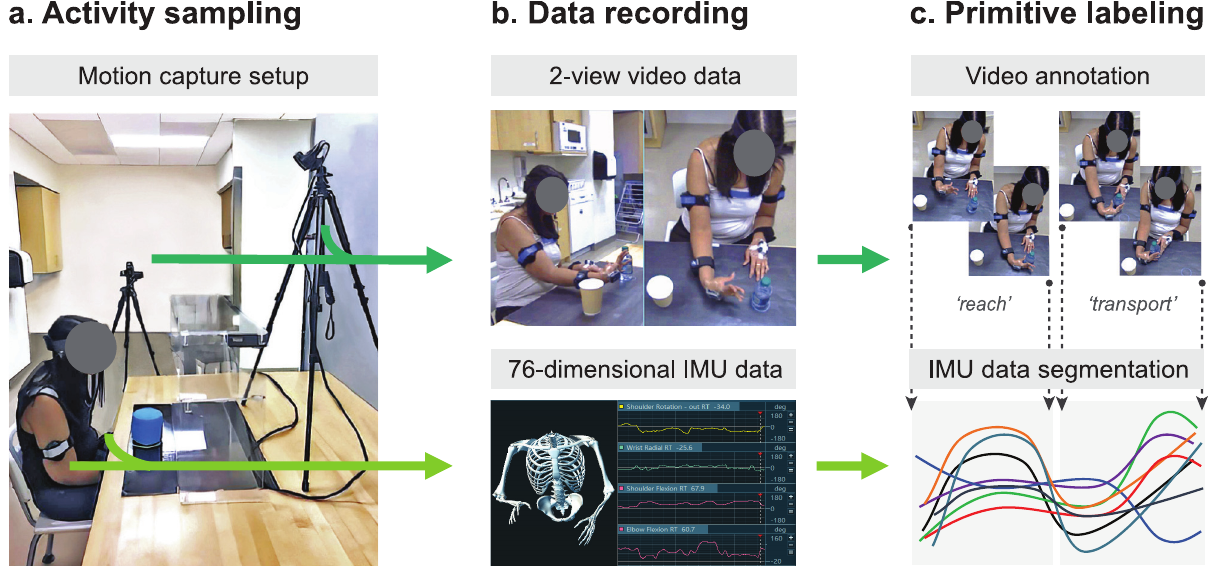
Fig 1. Functional motion capture and labeling. (A) Activity sampling . As patients performed rehabilitation activities, functional motion was synchronously captured with two video cameras (dark green arrow) placed orthogonal to the workspace and nine inertial measurement units (IMUs, light green arrow) affixed to the upper body. (B) Data recording . The video cameras generated 2-view, high-resolution data. The IMU system generated 76-dimensional kinematic data (accelerations, quaternions, and joint angles). A skeletal avatar of patient motion and joint angle offsets were monitored for electromagnetic sensor drift. (C) Primitive labeling . Trained coders used the video recordings to identify and annotate functional primitives (dotted vertical lines). These annotations labeled and segmented the corresponding IMU data. Interrater reliability was high between the coders and expert (Cohen’s K for reach, 0.96; reposition, 0.97; transport, 0.97; stabilization, 0.98; idle, 0.96).